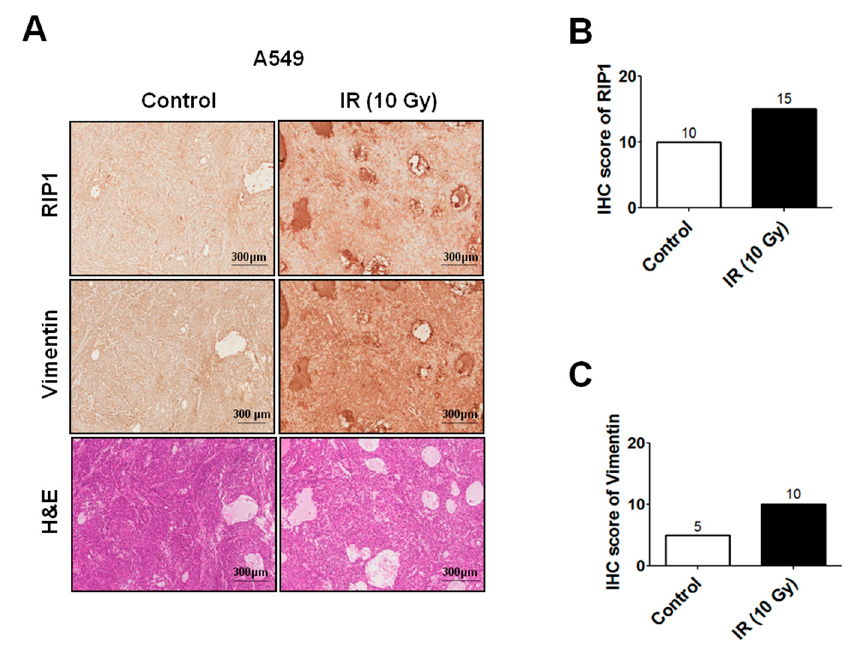
Figure 2. IR induces RIP1 and vimentin expression in a xenograft mouse model. ( A ) A549-tumor xenografts in response to sham irradiation or irradiation with 10 Gy. Tumors were harvested 48 h after irradiation. Immunohistochemical (IHC) analysis of xenografts tissues of mice after irradiation was performed with antibodies against RIP1 and vimentin. Hematoxylin and eosin (H&E) staining of xenografts tissues in mice after irradiation with 10 Gy. Scale bar indicates 300 µ m. ( B , C ). The IHC score for RIP1, vimentin is shown in ( B , C ), respectively. The correlation plot of IHC-score quantification for RIP1 and vimentin.